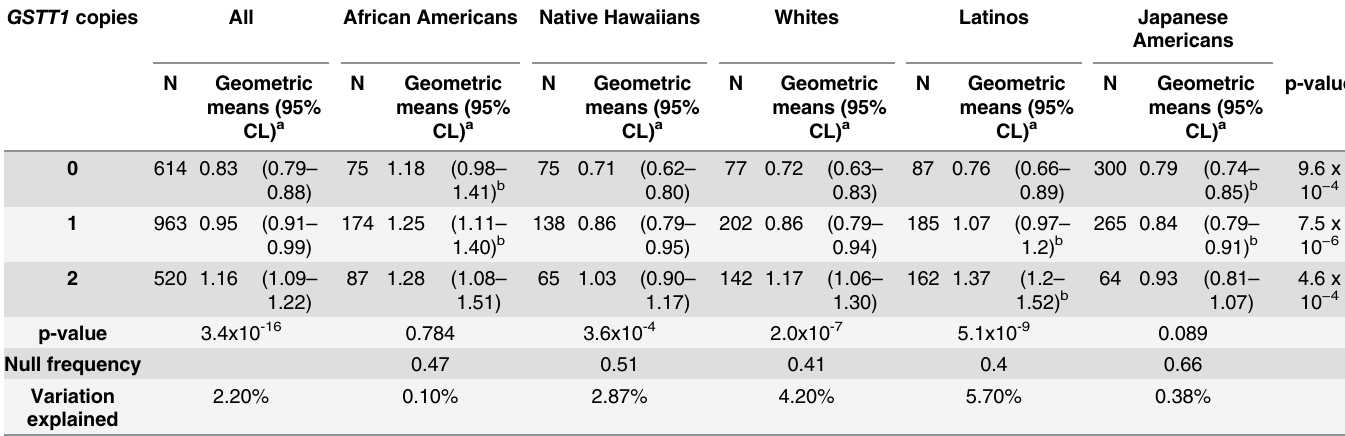
Table 5. Geometric means (95% CI) of PheT (pmol/mL) stratified by GSTT1 copy number variants and